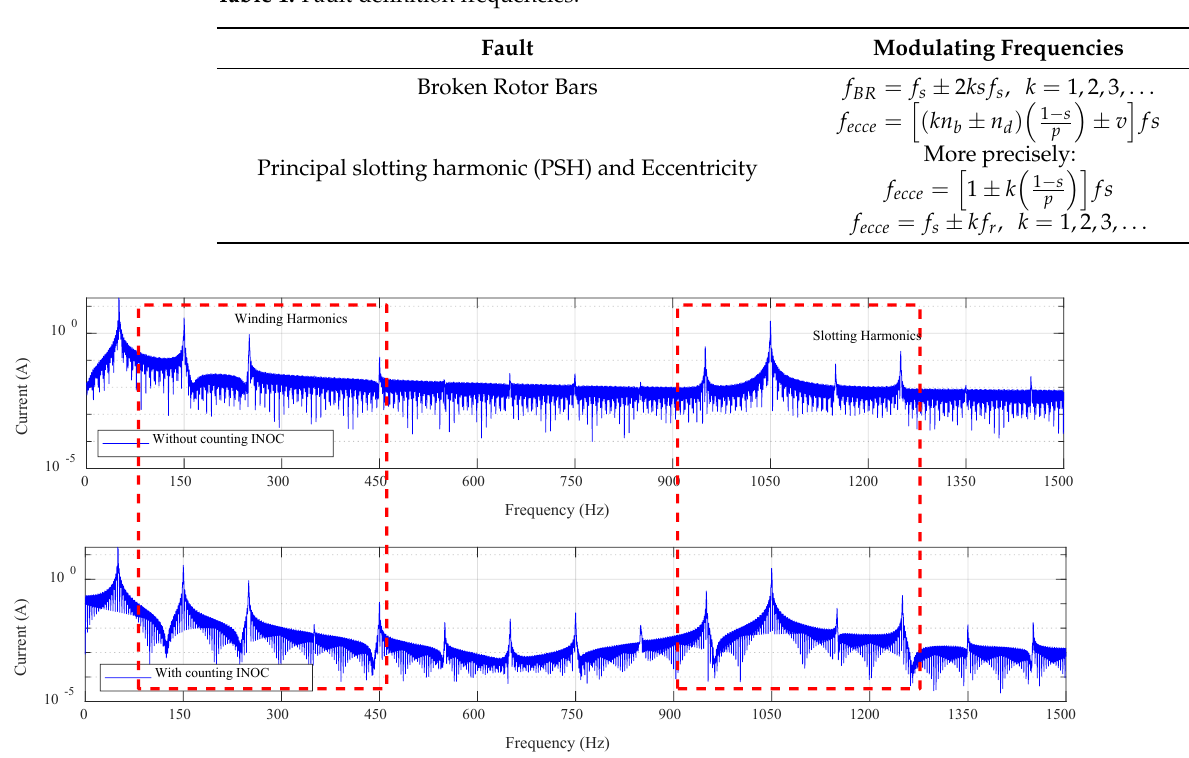
Table 1. Fault definition frequencies.